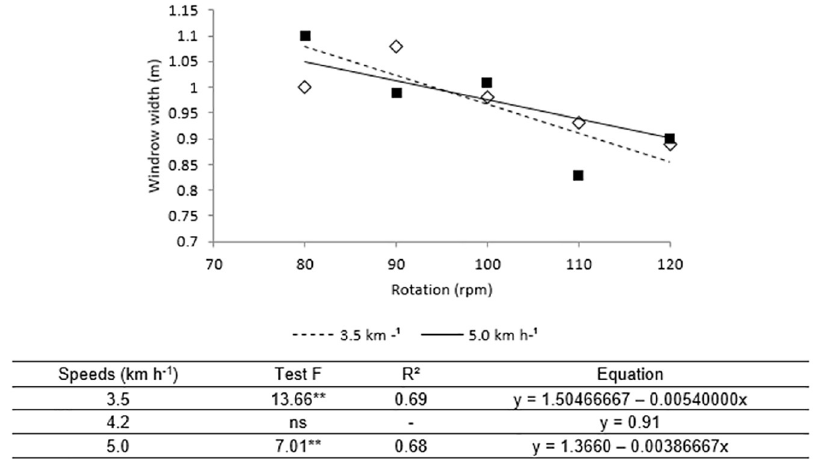
Fig 6. Windrow width versus conveyor belt rotation after the passage of the mechanized set at the velocities. The equation of adjustment of each interaction is shown below Fig 6, when this was significative by the F test ( �� p < 0.05). The speed 4.2 km h -1 did not obtain significant adjustment